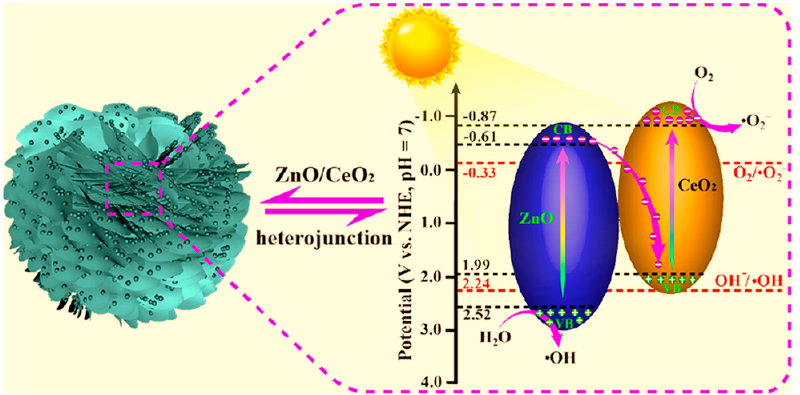
Figure 15. Schematic representation of ZnO/CeO 2 composites and charge transfer mechanism according to Z-scheme heterojunction [162].